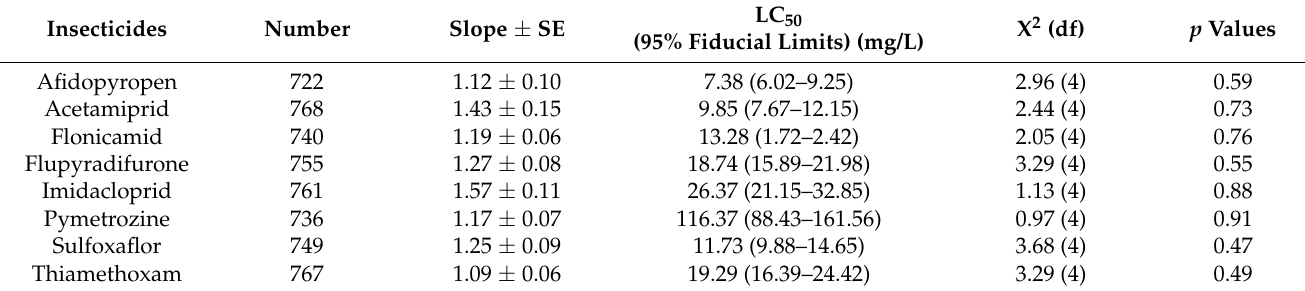
Table 1. Toxicities of eight commonly used insecticides in B. tabaci